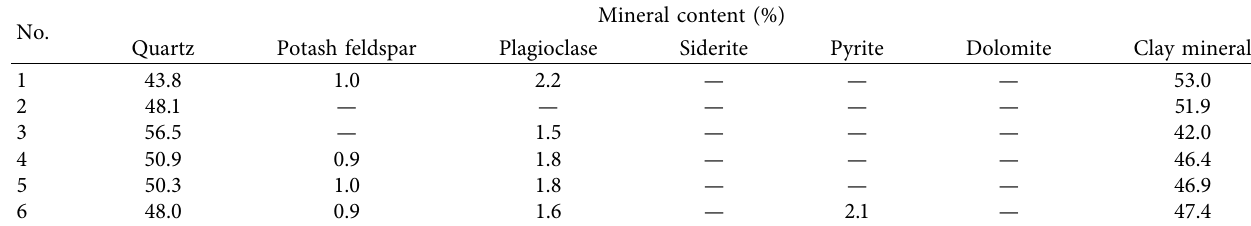
Table 2: Relative content of different minerals in the rock mass.